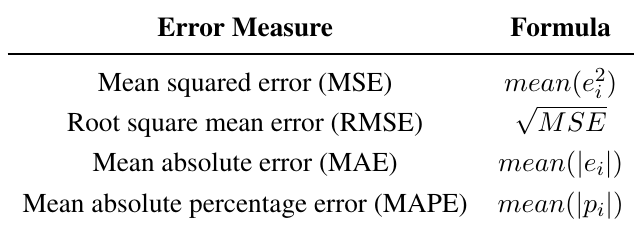
Table 1. Error measures used to assess the forecasting performances of the neural network auto regressive external input (NNARX)